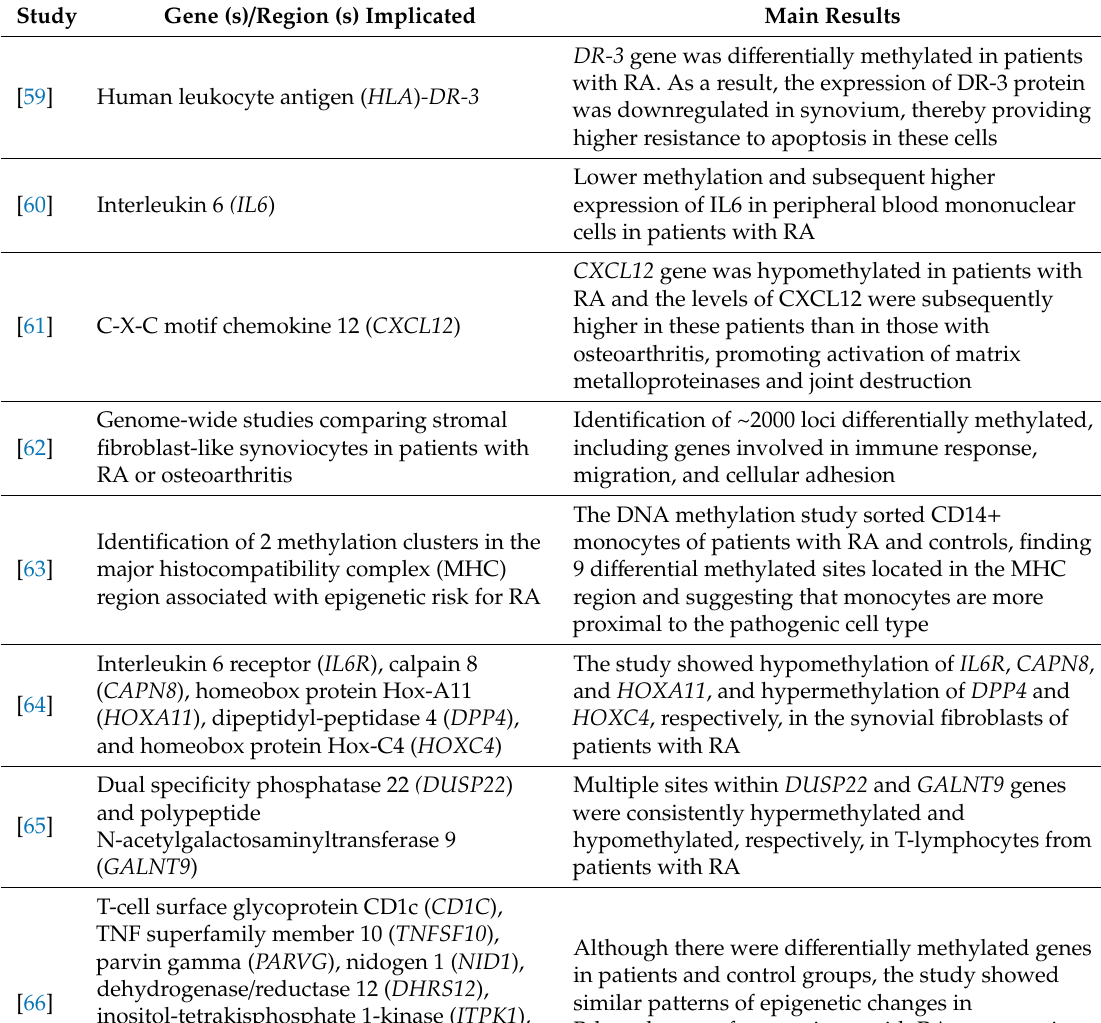
Table 2. Basic research studies showing specific changes in DNA methylation in patients with rheumatoid arthritis